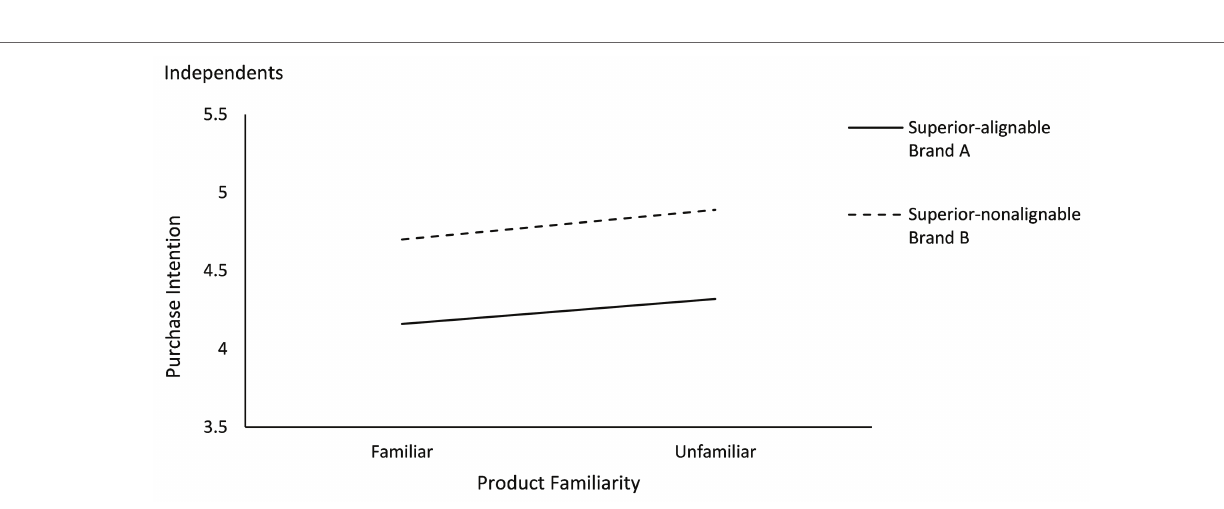
FIGURE 7 | Effects of product familiarity and attribute alignability on purchase intention for independents (study